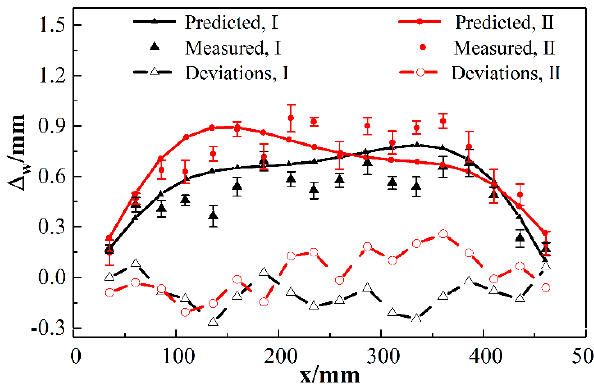
Figure 6. Clearances between the points to be joined on stringers and adjacent skin surface.